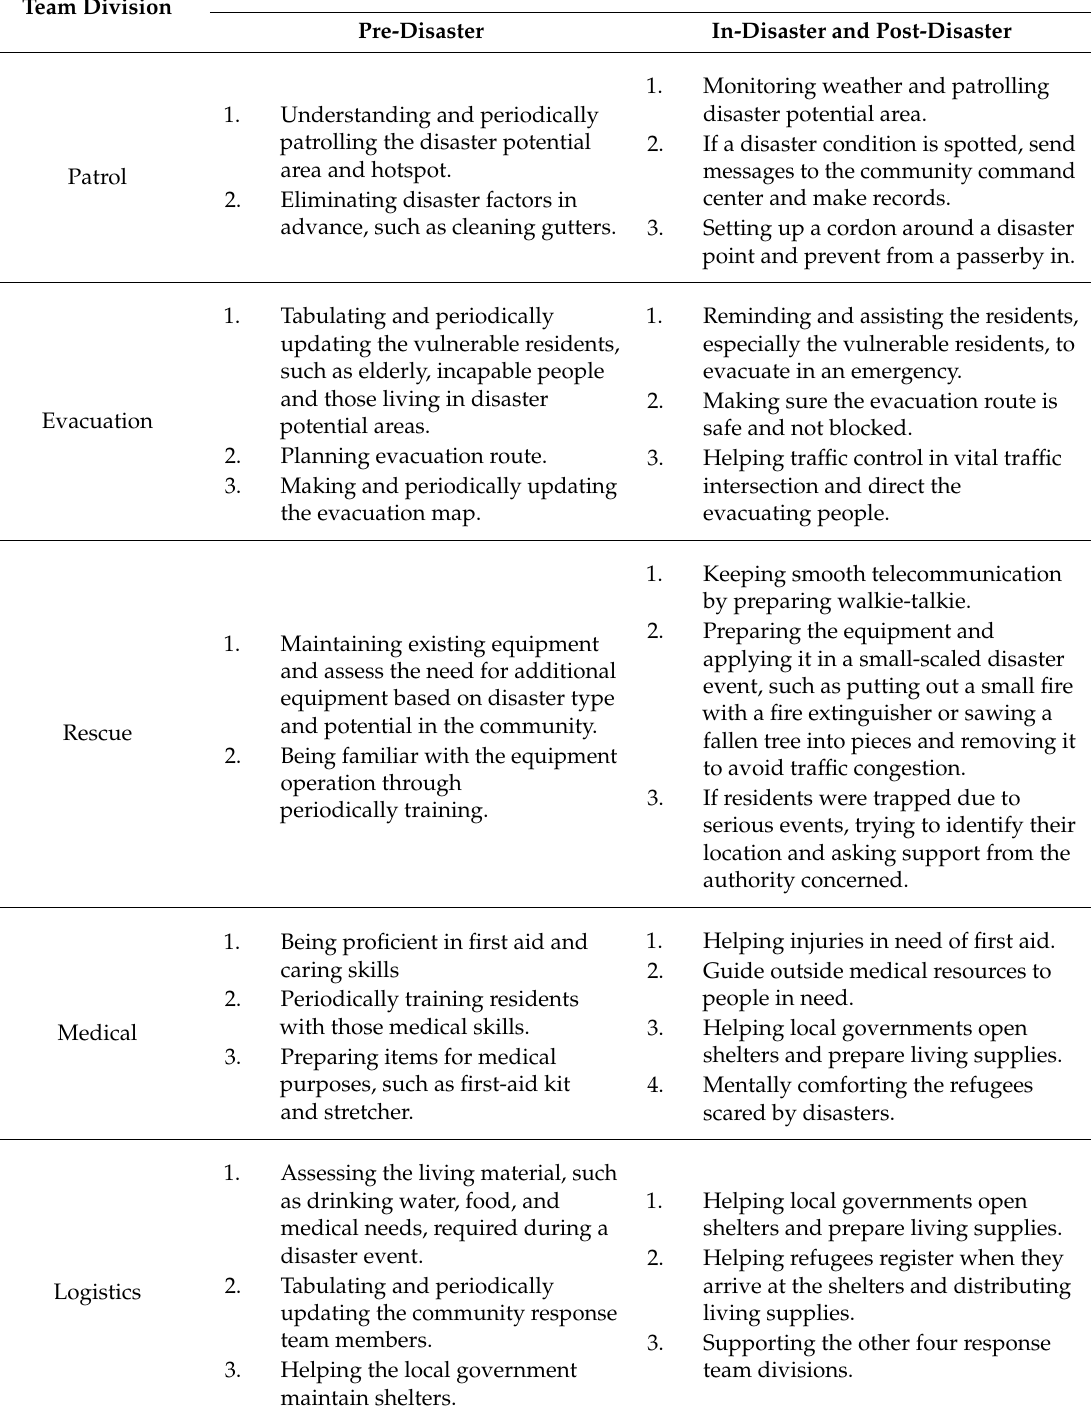
Table 1. The Function of the Community Response Team in NTPC. Team